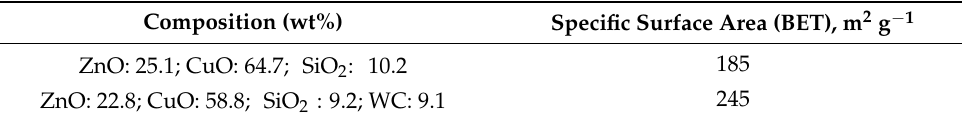
Table 1. Compositions and specific surface areas of the catalyst